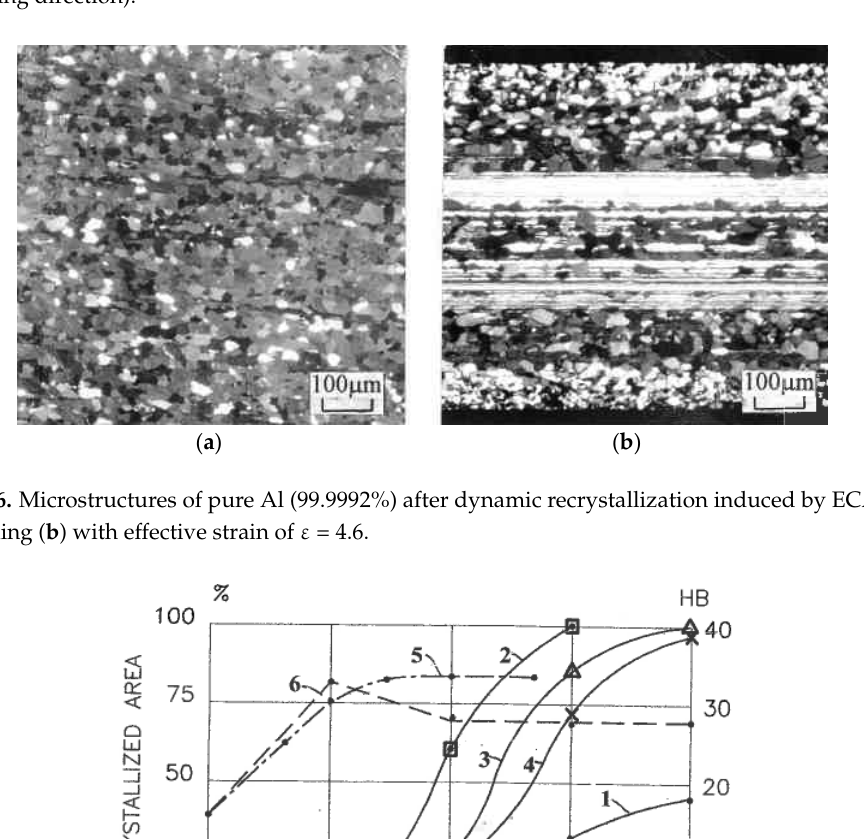
Figure 5. Shear band localization during ECAE ( a ) and rolling ( b ) of Al0.5%Cu alloy (SB-shear bands; RD-rolling direction).